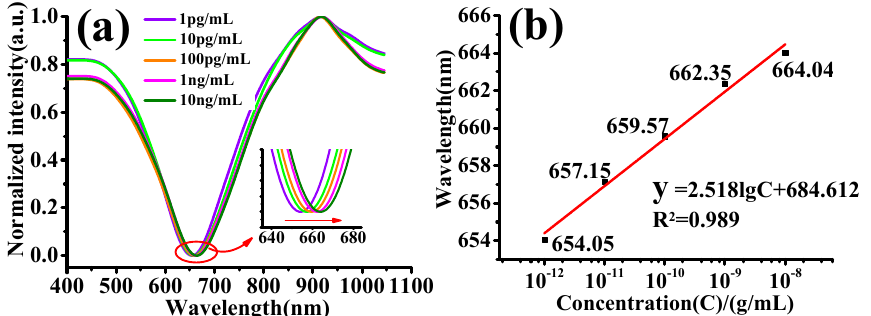
Figure 7. The test results of GDF11 concentration detected by twisted fiber SPR sensing probe: ( a ) SPR spectra of different concentrations of GDF11 antigen solution; ( b ) The relation curve of SPR resonance wavelength and solution concentration.